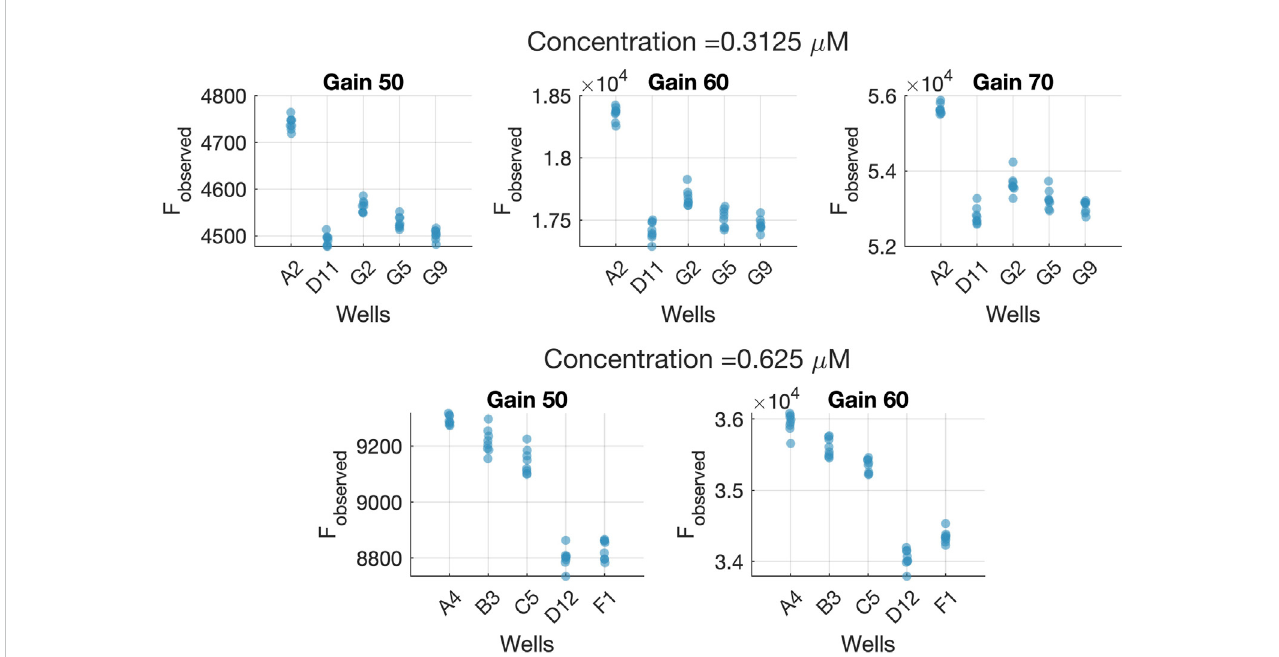
FIGURE 11 Observed fl uorescence values ( F observed ) for all wells in the 96-well plate with concentration values outside the calibration range used for the model building. Each row refers to one concentration level. Each plot contains the F observed values recorded at a certain Gain level. The horizontal axes indicate the speci fi c well identity (ID) yielding the F observed